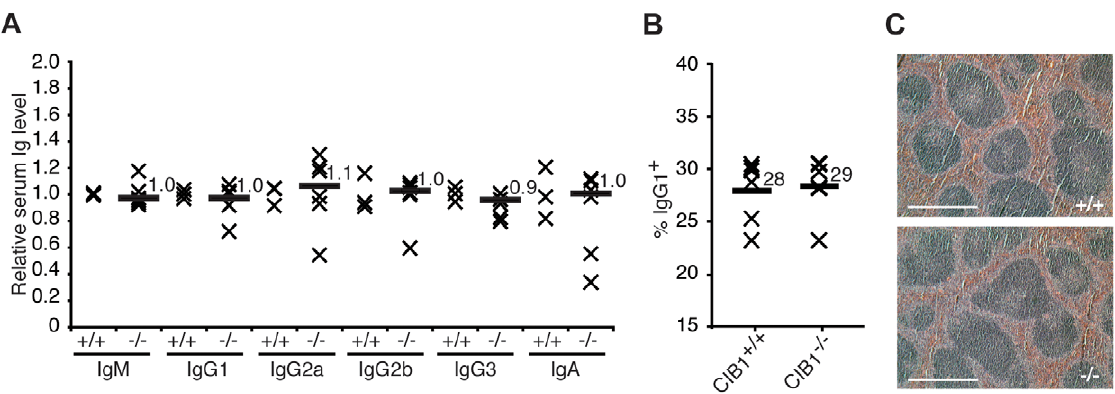
Figure 5. CIB1 is dispensable for CSR in mice. A . Relative levels of each antibody isotype in sera from CIB1 + / + or CIB1 2 / 2 mice as measured by ELISA. The CIB1 2 / 2 data were normalized to the mean antibody levels in sera from wildtype (WT) littermates (arbitrarily set to 1 for comparison). Each X represents data from an independent animal and the horizontal bars and labels report the median values (n=3 for CIB + / + and n=6 for CIB 2 / 2 ). B . IgM to IgG1 CSR ex vivo . B-cells were isolated from the spleens of CIB1 + / + or CIB1 2 / 2 mice, cultured for 4 days in the presence of LPS and IL-4, and analyzed by a -IgG1-PE labeling and flow cytometry. Each X represents data from an independent animal and the horizontal bars and labels report the median values. C . Images of hematoxylin and eosin stained sections of spleen isolated from CIB1 + / + and CIB1 2 / 2 mice. Scale bars indicate 500 m m.